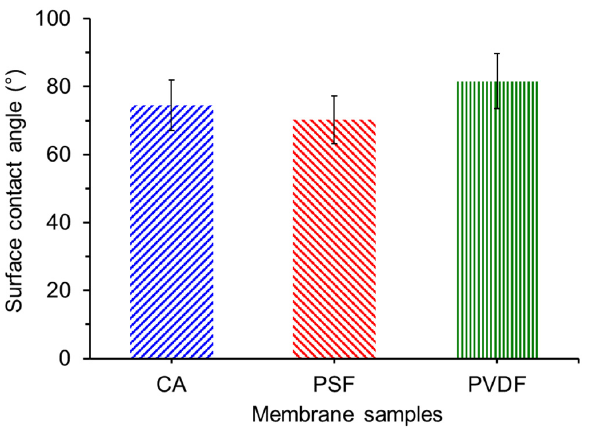
Figure 5. Static contact angle of the developed cellulose acetate (CA), polysulfone (PSF), and polyvinylidene difluoride (PVDF) membranes.